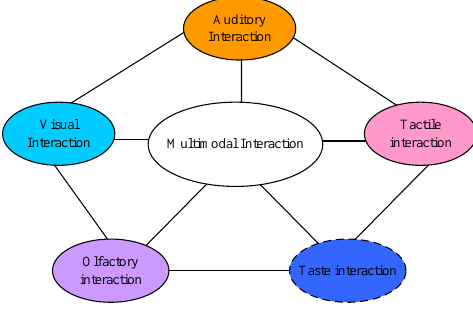
Figure 1. MID concept.